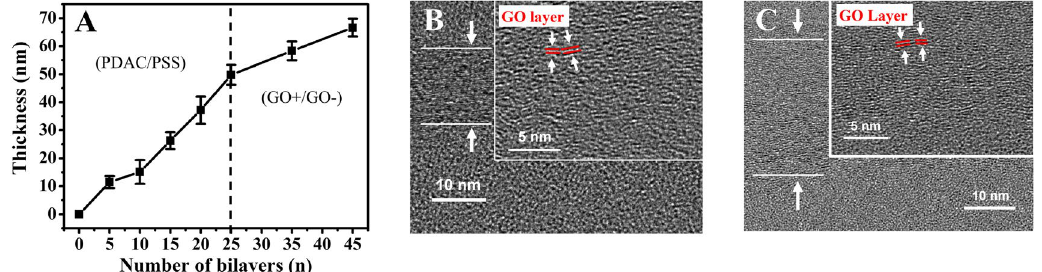
Figure 2. Thickness growth profile and TEM cross-sectional images. ( A ) Thickness growth profile of a spray-assisted LbL-assembled (PDAC/PSS) n (GO + /GO − ) n film. ( B ) TEM cross-sectional images of (PDAC/ PSS) 25 (GO/GO) 20.5 and ( C ) (PDAC/PSS) 25 (GO/GO) 40.5 . A higher magnification image is shown in the inset, which represents LbL-assembled GO